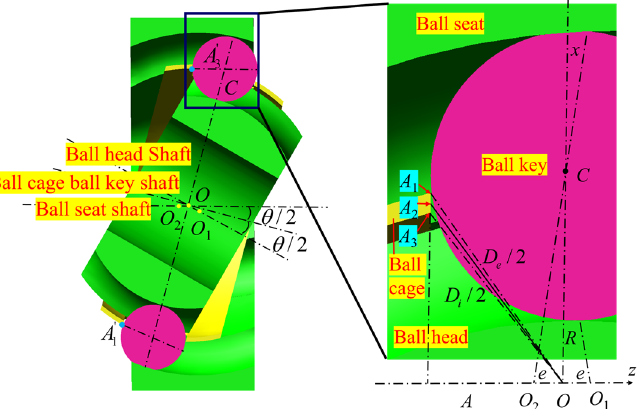
Figure 6. The geometric relation between the ball cage and the ball key when the angle between the shafts is θ .